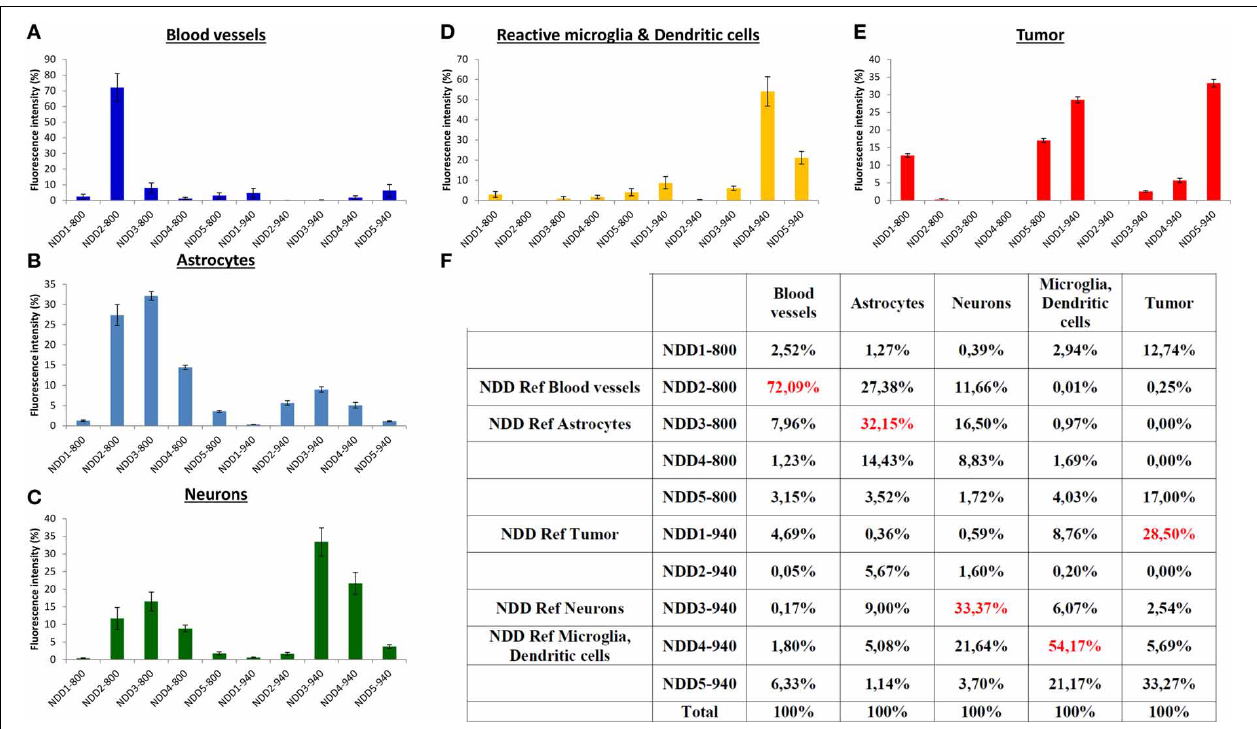
and 940nm (NDD1-940–NDD5-940). (F) Numerical values (%) used for spectral deconvolution (red: contribution of the element of interest in its reference